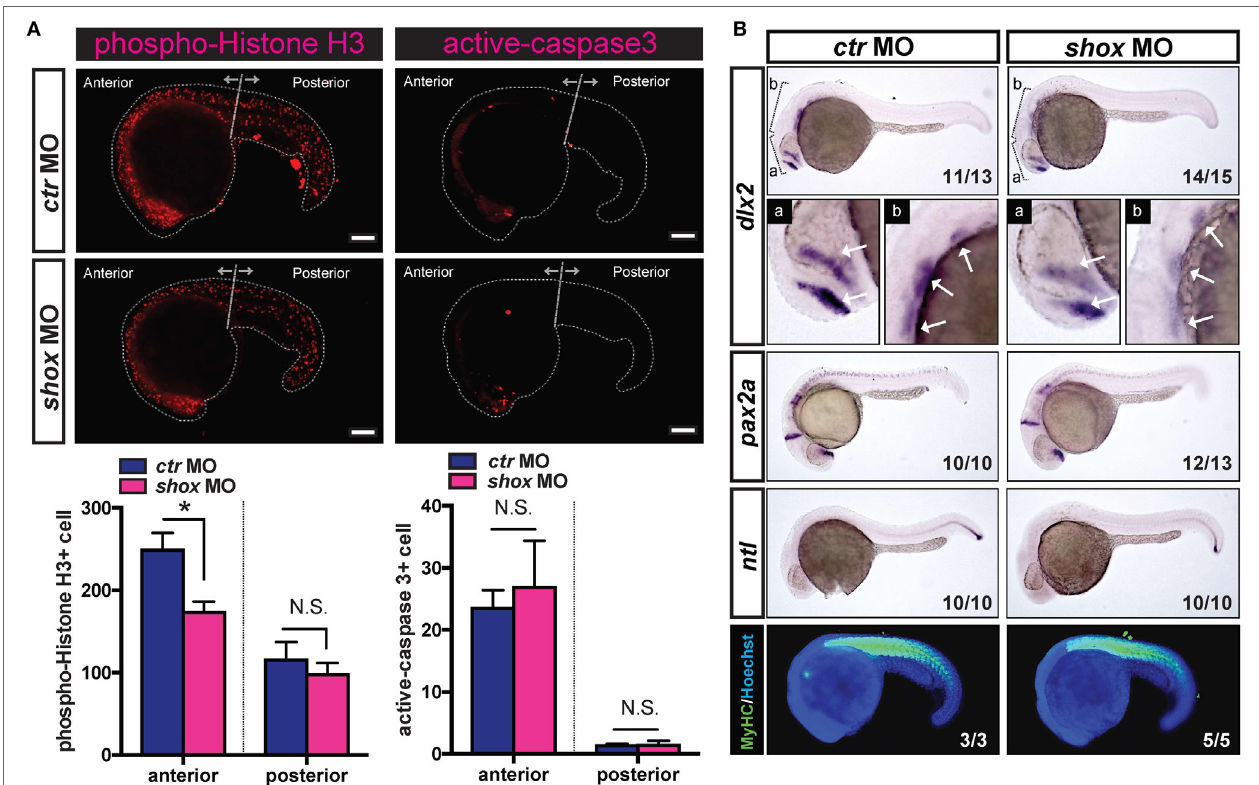
FigUre 1 | Translational blockade of zebrafish shox reduced cell proliferation and specific gene expression of skeletal progenitors in developing embryos. (a) Analyses of cell proliferation and cell death of shox morpholino oligo (MO) or control MO ( ctr MO)-injected 22 hpf embryos. Bars, 100 µm. Representative results of phospho-Histone H3-staining and active-caspase-3-staining. Quantification data of phospho-Histone H3-staining of ctr MO-injected embryos ( n = 5) and shox MO-injected embryos ( n = 9). * P < 0.05. Quantification data of active caspase-3-staining of ctr MO-injected embryos ( n = 3) and shox MO-injected embryos ( n = 9). (B) Whole-mount in situ hybridization analysis and whole-mount immunostaining of 24 hpf embryos. The cRNA probe either for dlx2 mRNA, pax2a , or ntl mRNA was used. The arrows indicate domains with dlx2 positive signals. Whole-mount immunostaining analysis of myosin heavy chain (MyHC) (green) and Hoechst33342 (blue) was conducted. Representative results are displayed and the penetrance is shown in the lower right corner of each